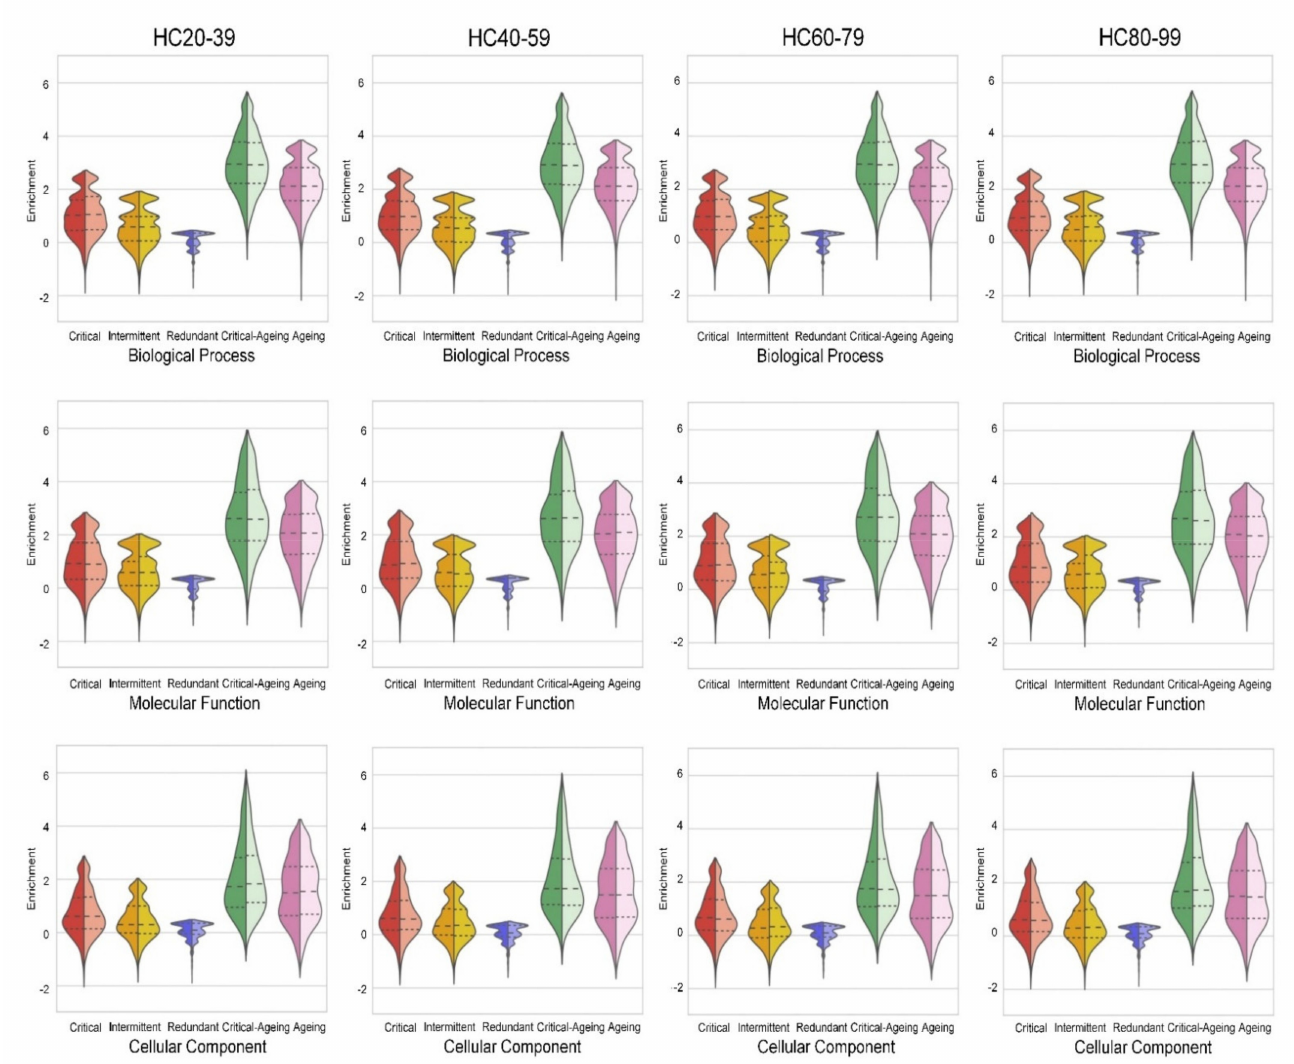
Figure 9. Violin-style plot of the proteins enriched for each gene ontology annotation in the HC brain region and each age period computed at probability Θ = 0.5: biological process, molecular function and cellular component. From left to right: enrichment of critical, intermittent and redundant proteins with each GO annotation. Ageing proteins identified as critical controllers showed the largest enrichment in the gene ontology functional categories. The last plot indicates the enrichment of well-known ageing genes in each GO annotation category. Each split violin plot shows the probability density of data in its left half (male) and right half (female) for comparison. The median for males and females was very similar and showed the largest enrichment for the critical-ageing category in both